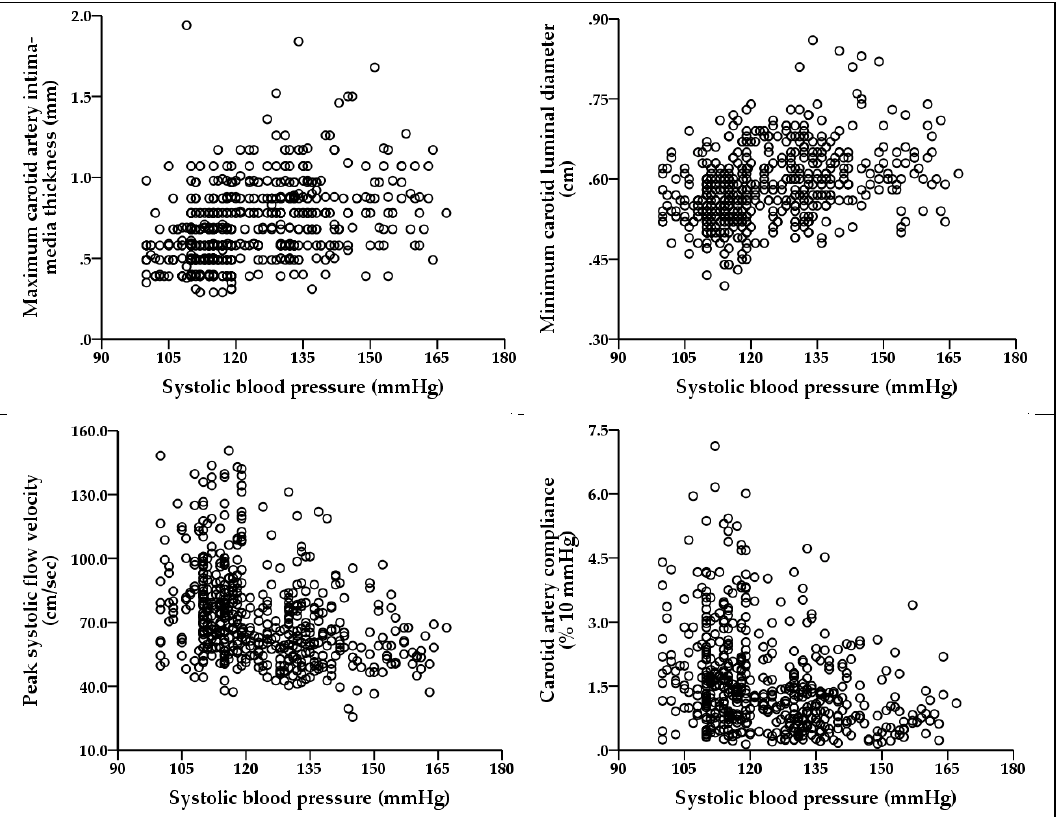
Figure 1. This scatterplot matrix figure illustrates the association (Pearson correlation coefficient, P value) between systolic blood pressure (SBP) and carotid artery intima–media thickness (r = 0.400, p < 0.001); SBP and minimum carotid artery luminal diameter (r = 0.308, p < 0.001); SBP and peak systolic flow velocity (r = − 0.361, p < 0.001); and SBP and carotid artery compliance (r = − 0.307, p < 0.01).